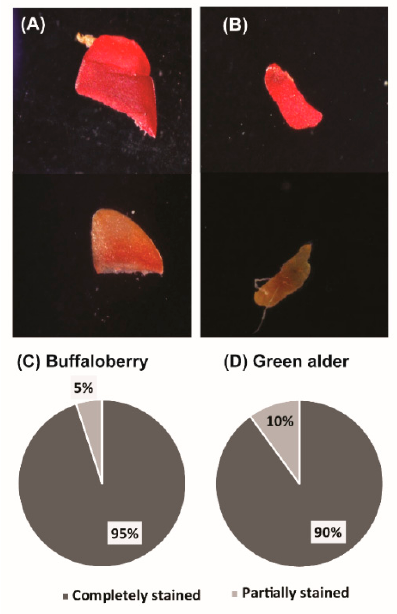
Figure 1. Tetrazolium test results showing viability of seeds following treatments. Stained and unstained seed of buffalo berry ( A ), stained and unstained seed of green alder ( B ) and percentages of completely stained ( C ), and partially stained seeds ( D ).